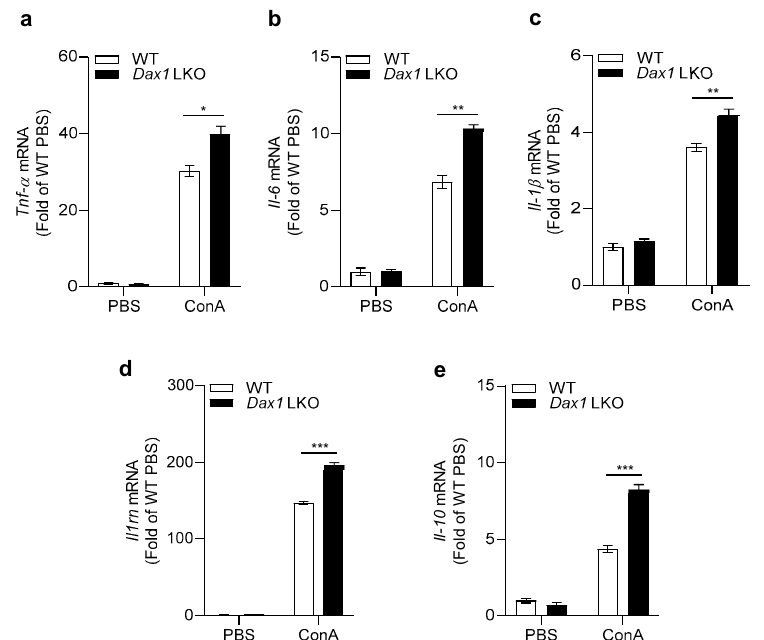
Figure 3. Hepatocyte-specific DAX1 deletion upregulates inflammatory cytokine expression follow- ing ConA administration. WT and Dax1 LKO mice were treated with a single administration of ConA (15 mg/kg, i.v.) or phosphate-buffered saline (PBS). The liver samples were harvested at 6 h (PBS; n = 3, ConA; n = 6) post treatment. ( a – c ) Expression of pro-inflammatory cytokines ( Tnf- α , Il-6 , and Il-1 β ) and ( d , e ) anti-inflammatory cytokines ( Il1rn and Il-10 ) determined using RT-qPCR (three technical replicates for each pooled sample from mice). Data are expressed as the mean ± SEM. Tukey–Kramer test after the one ‐ way ANOVA was used to compare the ConA ‐ treated LKO and ConA ‐ treated WT groups; * p < 0.05, ** p < 0.01, and *** p < 0.001.